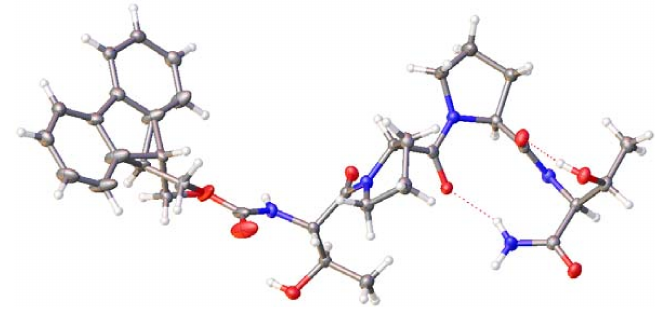
Figure 3. Crystal structure of 7